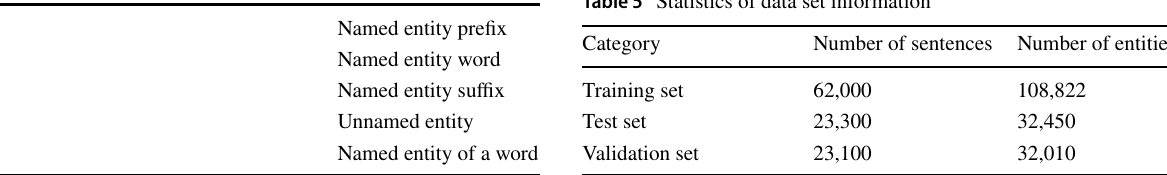
Table 3 Comparison of entity labels and their meanings Entity tagging